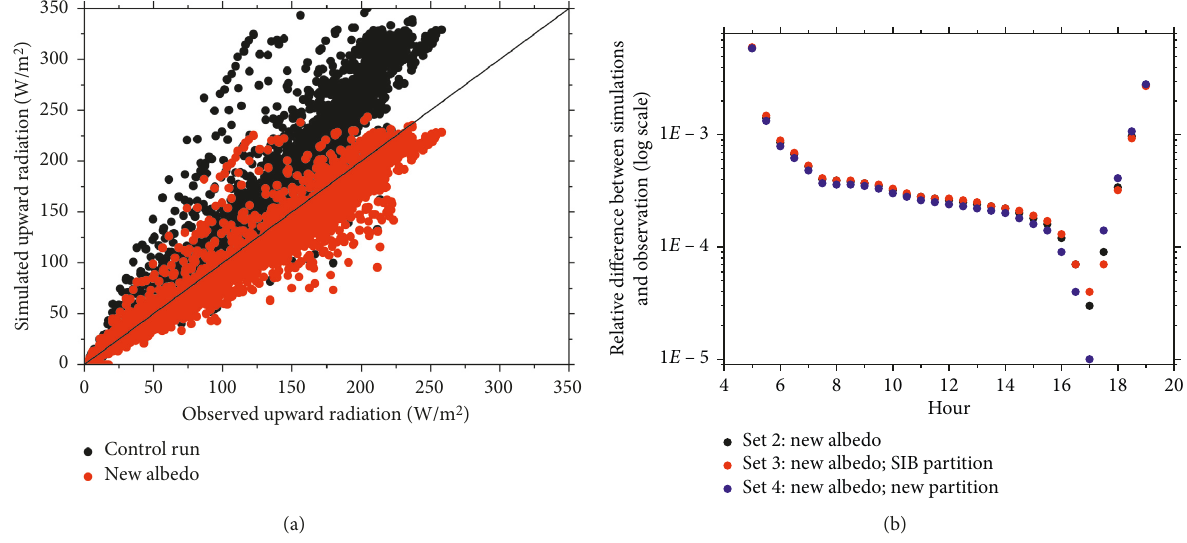
Figure 5: (a) Comparison of the simulated upward solar radiations for the control run and the set 2 with those of the observations for the whole year. (b) Annual averaged diurnal cycle of the relative differences between the simulated upward solar radiations for the set 2, set 3, and set 4 with those of the observations. Table 2: Biases, mean errors (MEs), root mean square errors (RMSEs), and correlation coefficients (Rs) of the upward solar radiation simulated by the four sets of experiments compared with those of the observations for the whole year. Biases (W/m 2 ) MEs (W/m 2